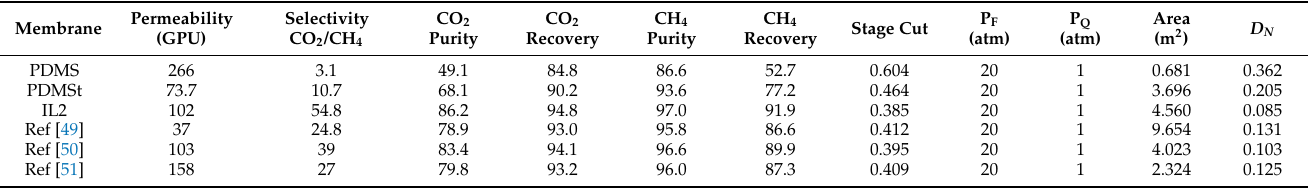
Table 5. Comparison of the optimal process performance parameters of the PDMS, PDMSt and IL2 membranes to other innovative membranes from referenced studies.